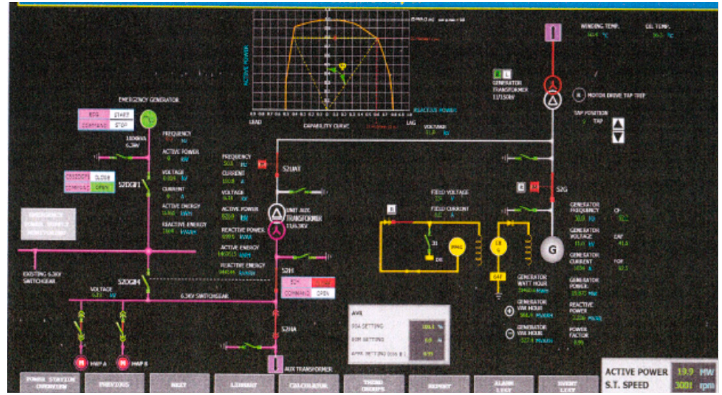
Figure 16. Original capability curve from the generator in Lahendong IV geothermal power plant. A comparison of original generator capability curves and the simulation results is shown in Figure 17.